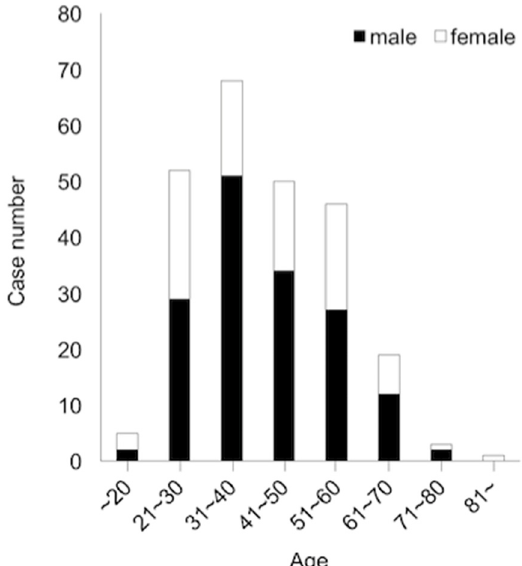
Figure 2. The age and gender distribution of 257 patients with dentigerous cysts developed around a mandibular third molar. mandibular third molar.